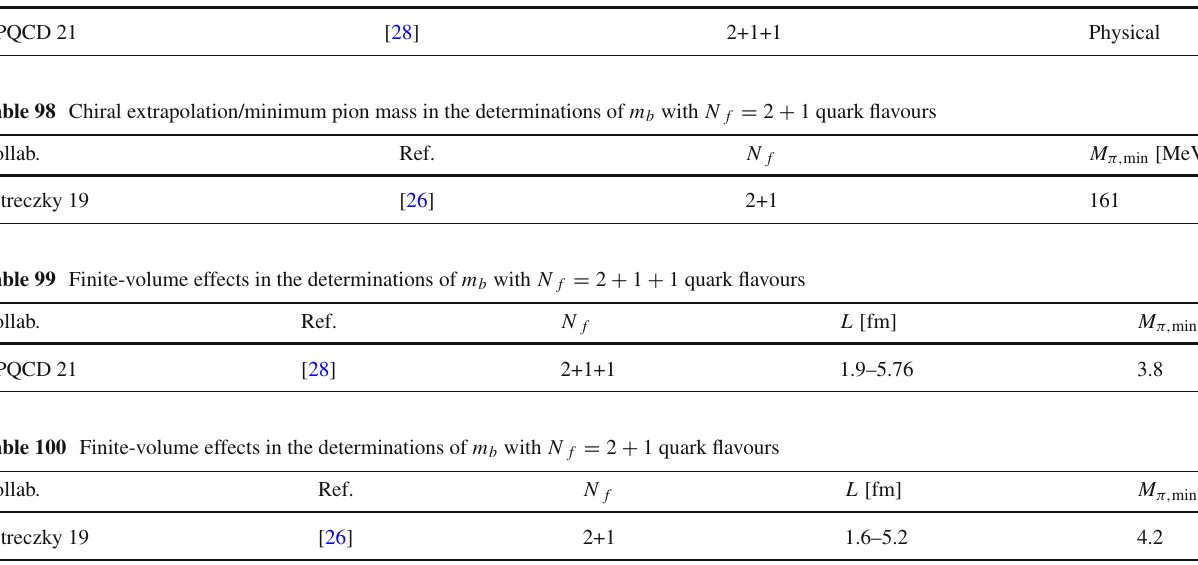
Table 97 Chiral extrapolation/minimum pion mass in the determinations of m b with N f = 2 + 1 + 1 quark flavours Collab.